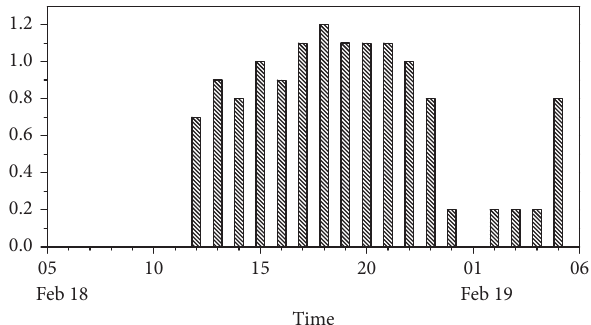
Figure 2: Hourly snowfall at the Xinyuan station (unit: